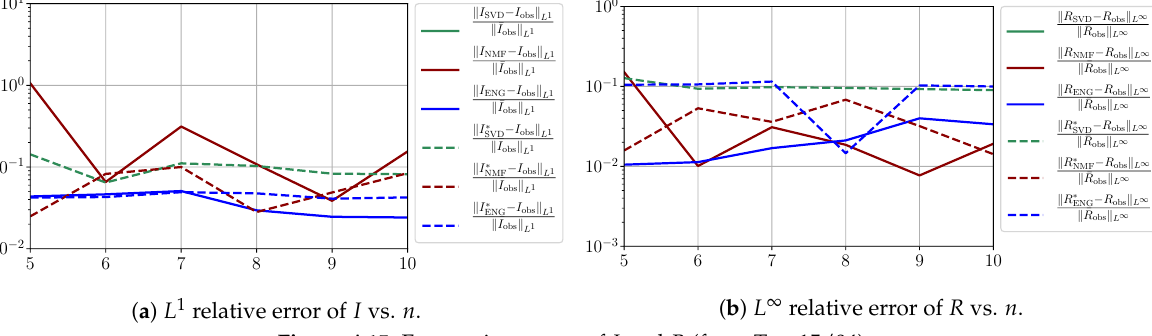
Figure A15. Forecasting errors of I and R (from T = 15/04).